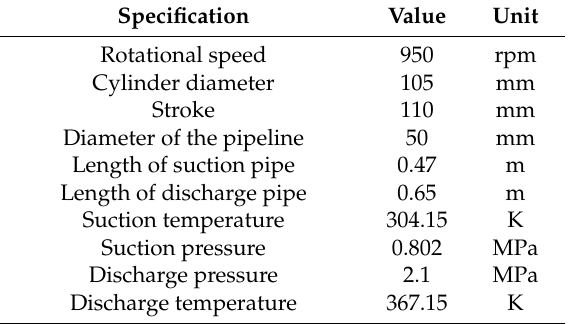
Figure 5. The examined chamber: ( a ) fluid domain and ( b ) finite element mesh. Table 1. Main specifications of the reciprocating compressor.